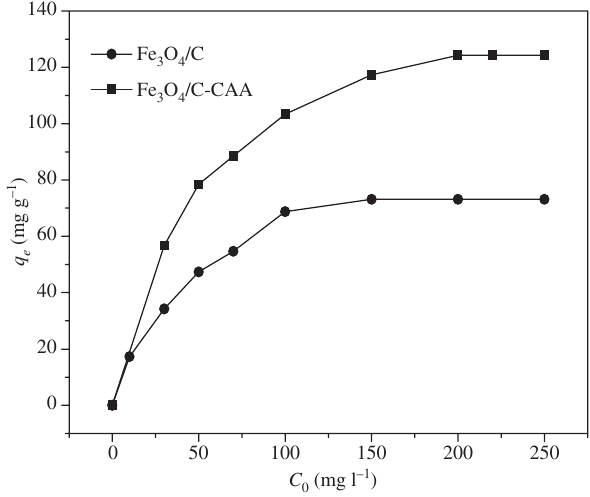
Figure 12: The effect of initial MB concentration on the adsorption of MB by Fe O /C and Fe O /C-CAA microspheres at pH 11 and 25 ° 3 4 3 4